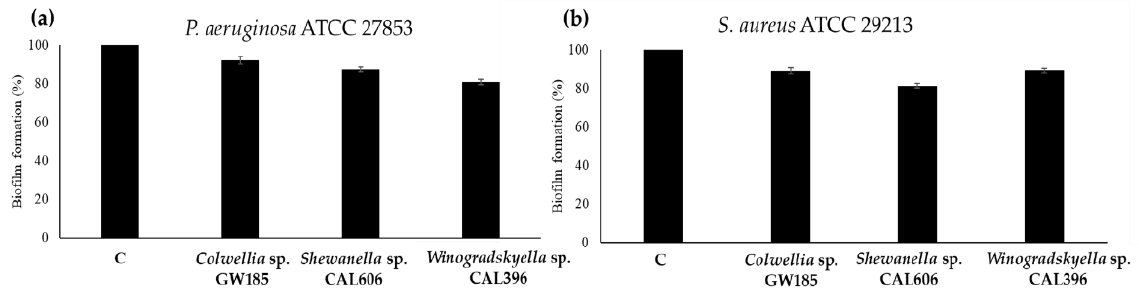
Figure 3. Biofilm formation by ( a ) P. aeruginosa and ( b ) S. aureus , after 48 h and 24 h treatment, respectively, in absence (Control, C) or in presence of crude extracts (400 µg/mL) from Colwellia sp. GW185, Winogradskyella sp. CAL396 and Shewanella sp. CAL606.